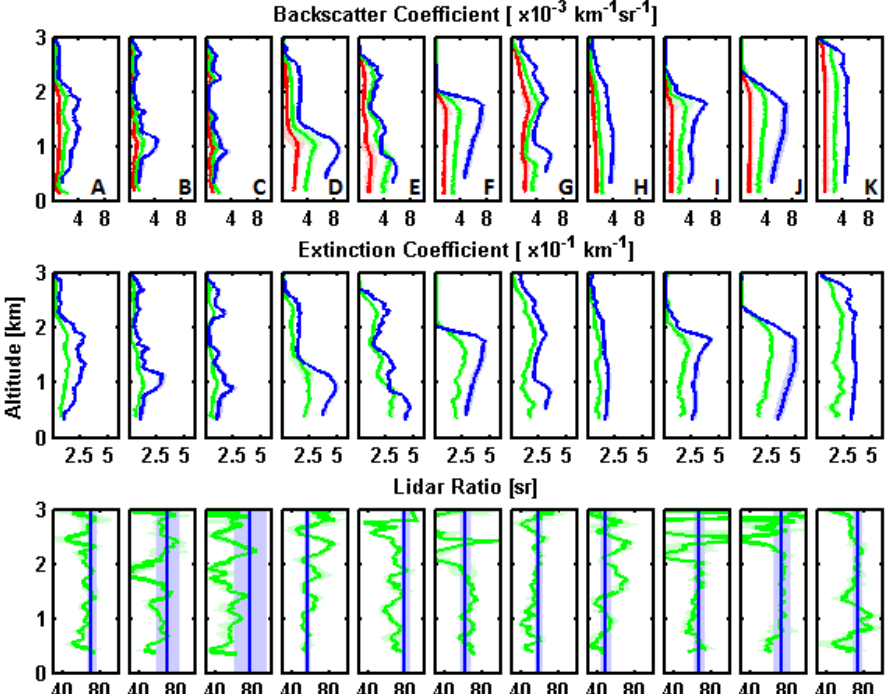
Figure 5. 3 β + 2 α and lidar ratio values obtained from the hybrid multiwavelength lidar data set. Green and red lines are airborne profiles at 532nm (HSRL) and 1064nm (elastic), respectively. Blue lines are from ground-based elastic lidar at 355nm. Letters correspond to each case analyzed, which are listed in detail in Table